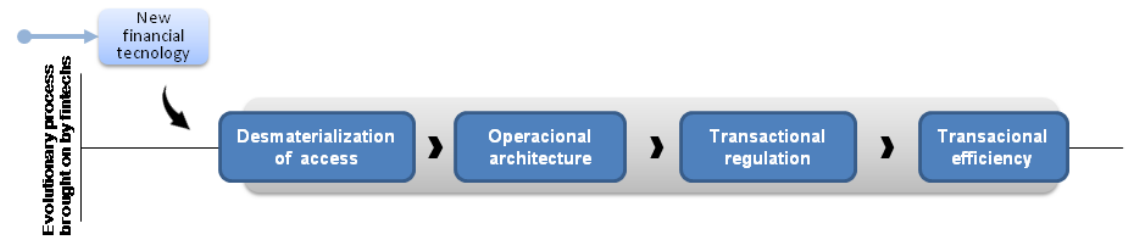
Figure 3. Stages of the evolutionary process brought on by fintechs. Source: the authors.